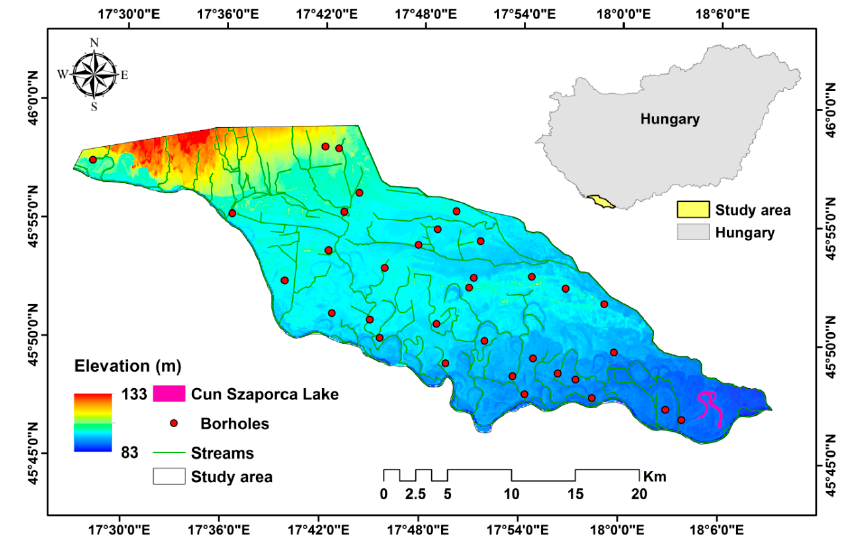
Figure 1. Location of the Drava River floodplain, SW Hungary, with water-courses, existing (C ú n-Szaporca) lake, and